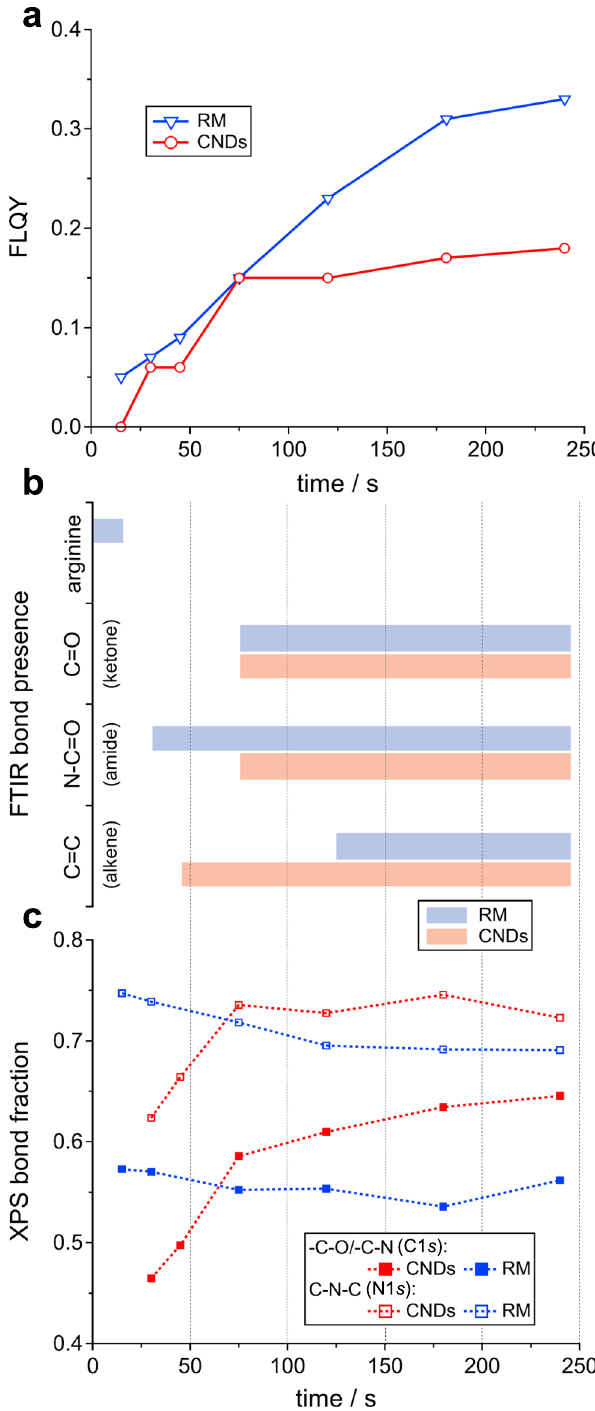
Fig. 3 Chemical modi fi cations over time. a Fluorescence quantum yields (FLQY) of CNDs and RM for 15 – 240s. b FTIR bond presence of RM and CNDs at 15 – 240s. c XPS bond fraction (C1 s and N1 s ) of CNDs and RM at 15 – (15 s) and not in the spectra of CNDs; (ii) the FT-IR spectra of the RM share more similarities than CNDs with the absorption peaks of the small particles and polymers removed during dialysis. The amide (C = O) stretching moves from 1695 to 1705 cm − 1 in the spectra of the RM as the reaction proceeds and the same peak at 1705 cm − 1 is observed in the spectra of the CNDs after 120 s.